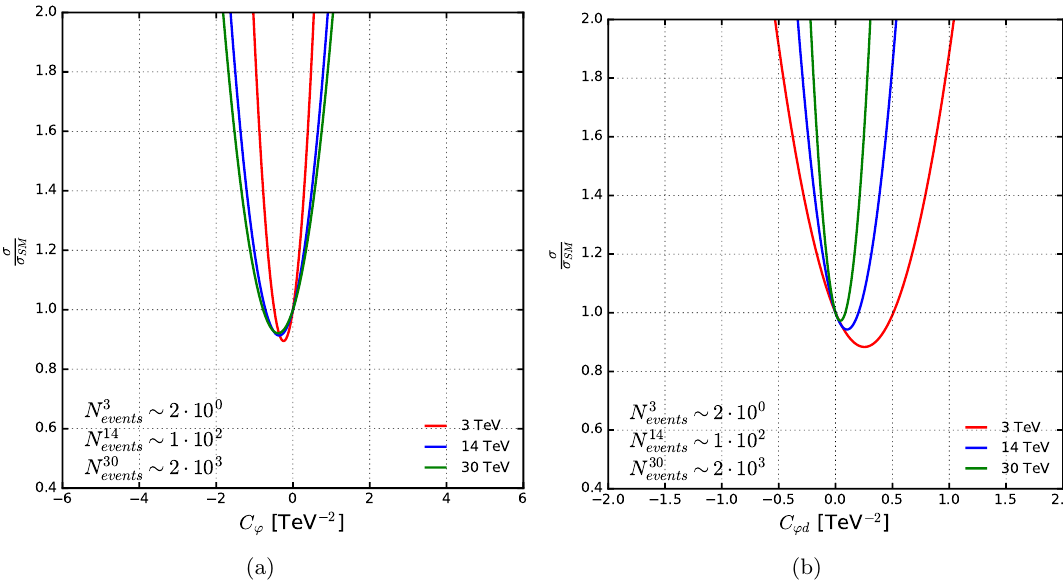
Figure 6 . Same as (cid:12)gure 5 but for triple Higgs production from